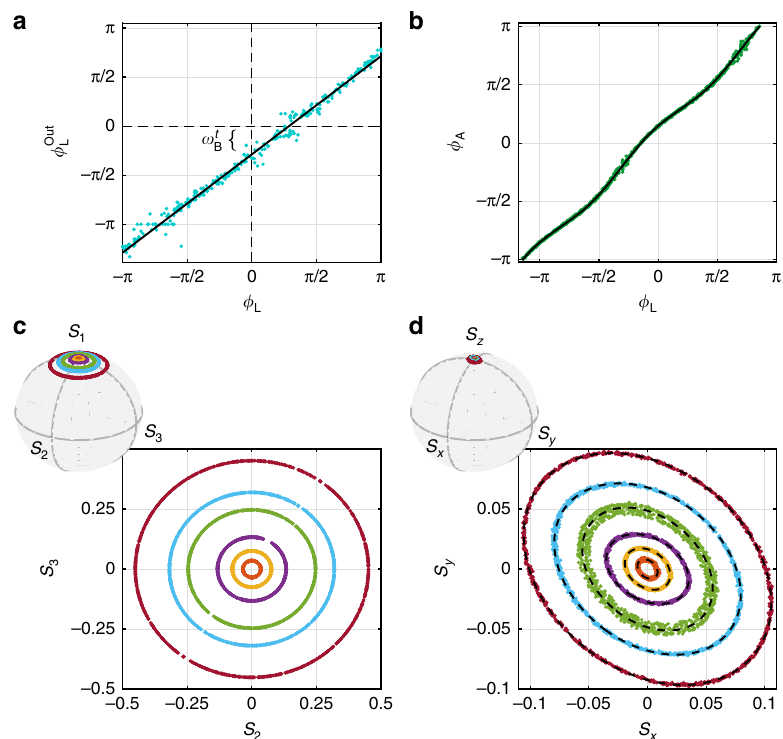
Fig. 4 Mapping from light polarization to spin orientation and back. a The measured phase of the retrieved light after storage for t = 100 ms follows the input phase up to an offset (line is a linear fi t with unity slope). b The azimuthal angle of the collective atomic spin versus the incoming optical phase (line is a fi t to elliptical mapping, see Supplementary Note 1). c Light polarization visualized on the Poincaré sphere and projected onto the transverse plane. d Collective atomic spin visualized on the Bloch sphere and projected onto the transverse plane. Data in b – d taken 1 ms after storage (without retrieval)